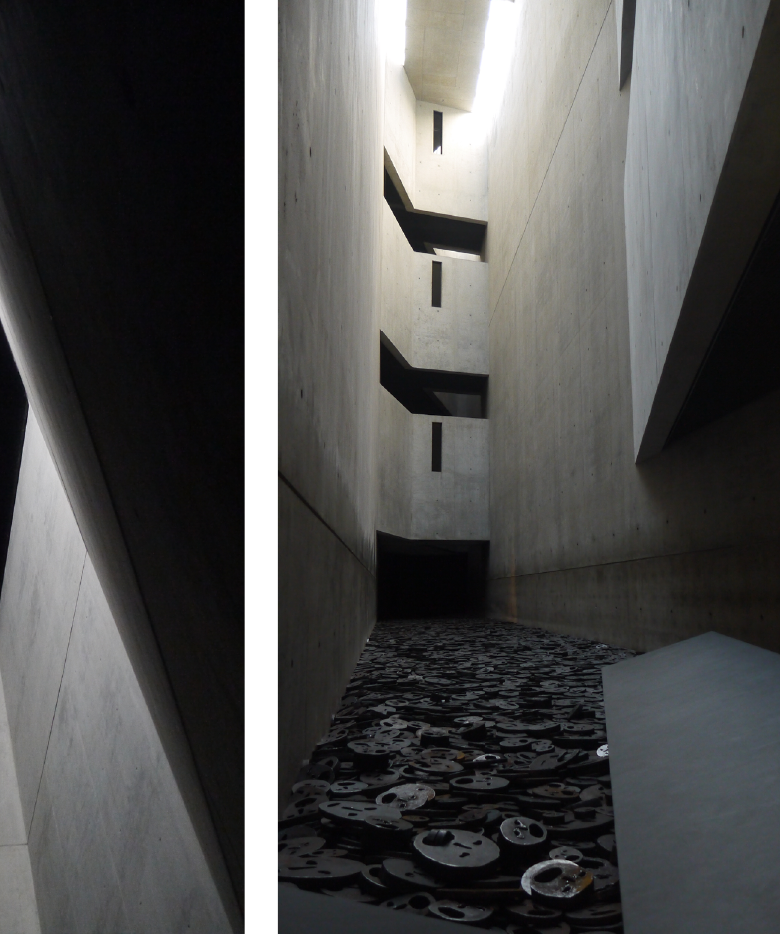
Figure 1. The interior of the Holocaust Tower Figure 2. The interior of the Memory